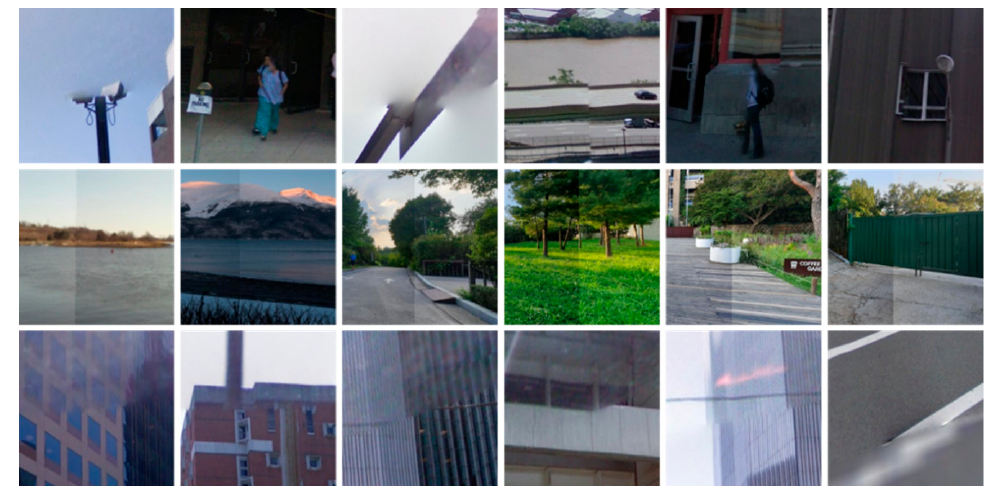
Figure 4. Representative distorted stitched patches from Google Street View Dataset [49] in test set A.